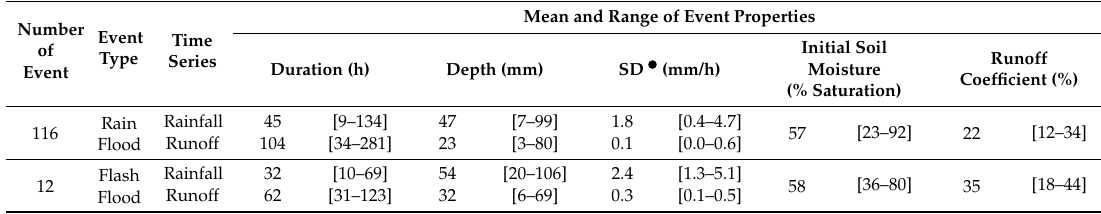
Table 2. Mean and range of event properties for rain flood and flash